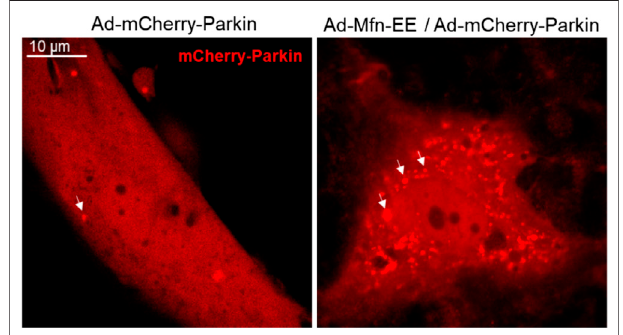
FIGURE 5 | Phosphorylated Mfn2 recruits Parkin to OMM. Mfn2 Thr 111 (T111) and Ser 442 (S442) were replaced by Glu (E) that mimics PINK1 phosphorylation of Mfn2 (T111E/S442E) conferred it PINK1-independent binding activity to